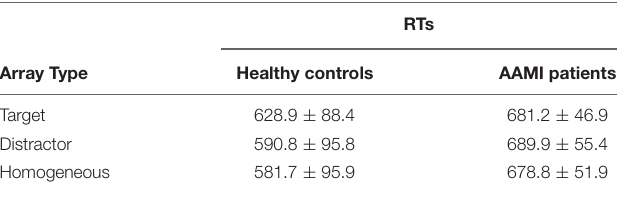
TABLE 1 | Mean reaction times (RTs, ms) and their corresponding standard deviations as a function of array type in healthy older adults and AAMI